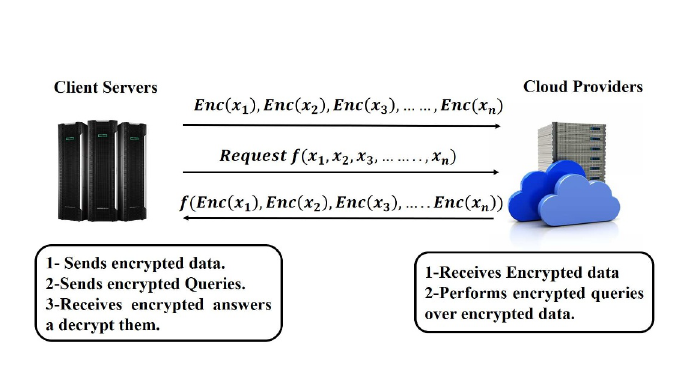
Figure 2: Cloud Querying using